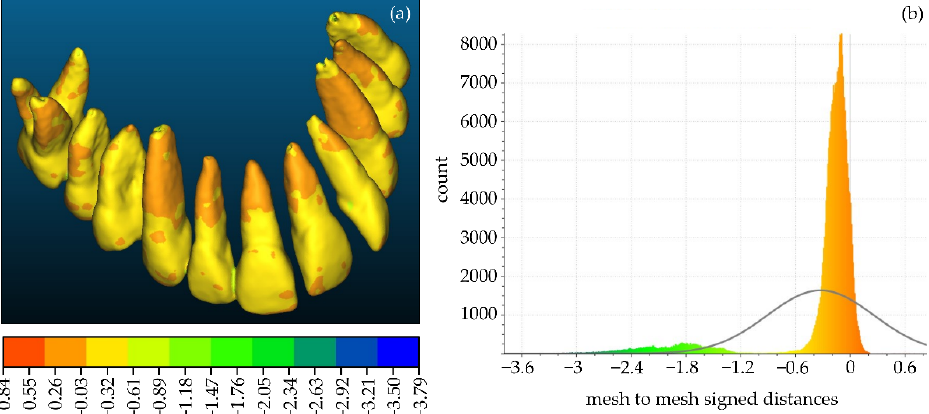
Figure 17. ( a ): Differences between the manually segmented 3D model of teeth of Experiment 2 (reference model) and the semi-automatically segmented 3D model of teeth of Experiment 4 (com- parison model), visualized in the comparison model; ( b ) the histogram of the distances between the aforementioned 3D models of teeth.